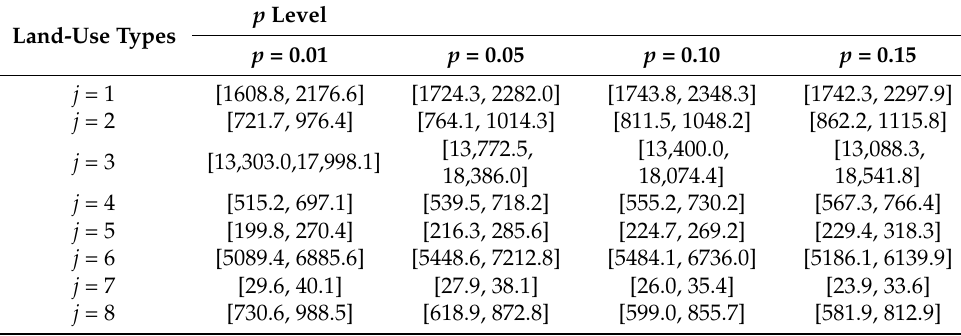
Figure 4. Optimized land-use allocation under p of 0.10 and 0.15 ( k = 1). Table 3. Optimized land-use patterns under different p levels at t = 1 and k =